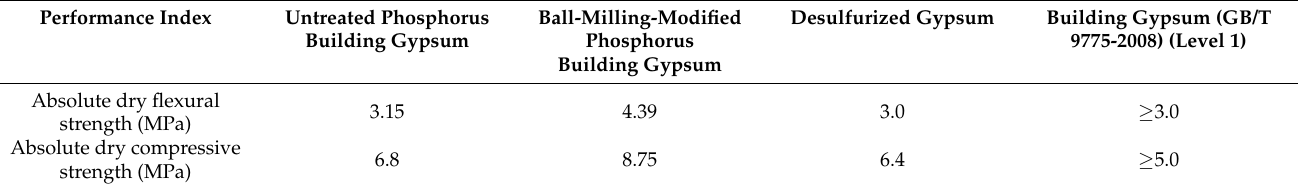
Table 9. Comparison of ball-milling-modified phosphorus building gypsum and other gypsum